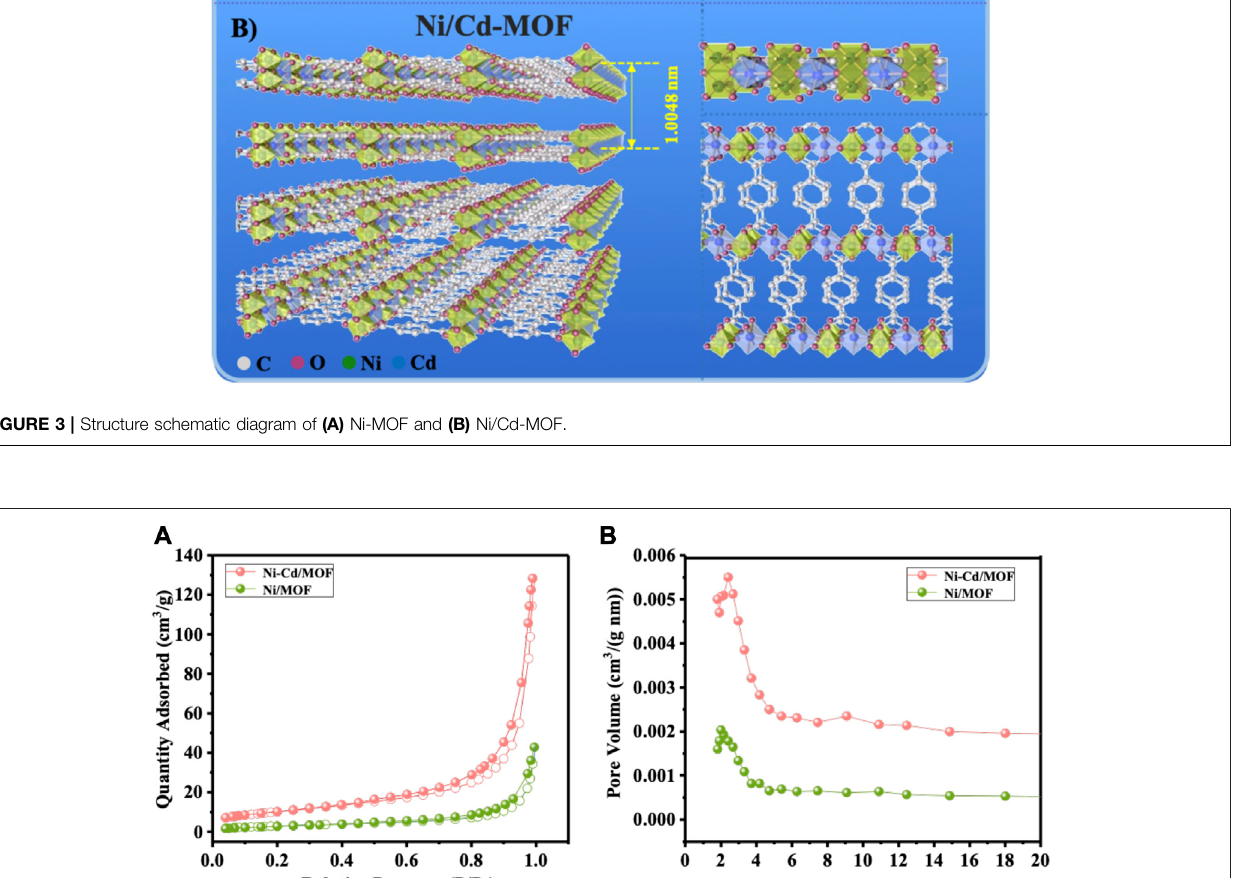
Table S1 . Pb with ionic species [Pb 2+ and Pb(OH) + ] are mainly